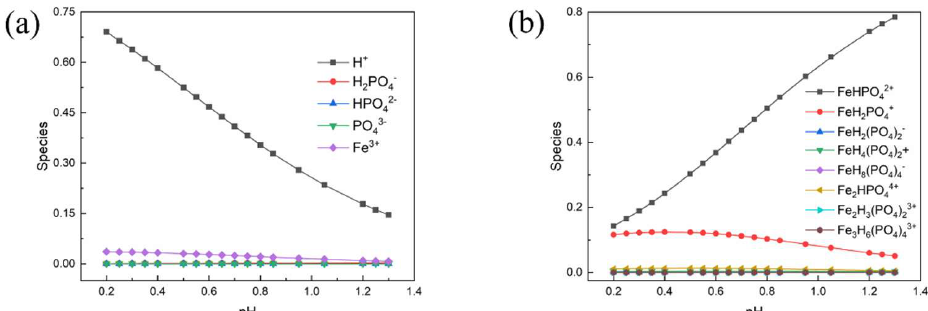
Figure 2. Distribution of the various complexation species under different pH environments: ( a ) shows distribution of H + , H 2 PO 4− , HPO 42− , PO 43− and Fe 3+ ; ( b ) shows distribution of the rest of the ions. Table 4. Possible reactions in solution with an initial pH value of 0.85. No.